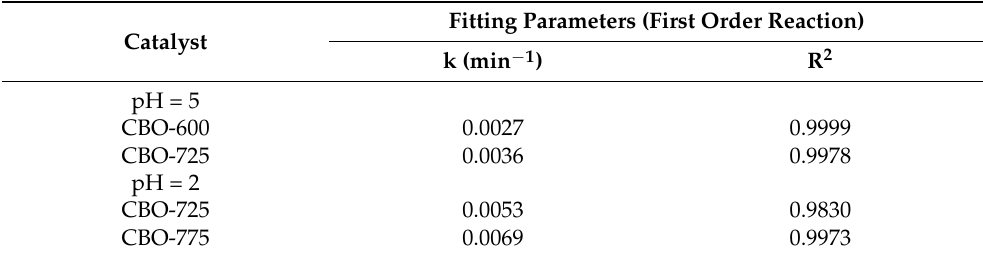
Table 3. Kinetic parameters resulting from the linear plotting of the first order reaction for the photodegradation of RhB over all